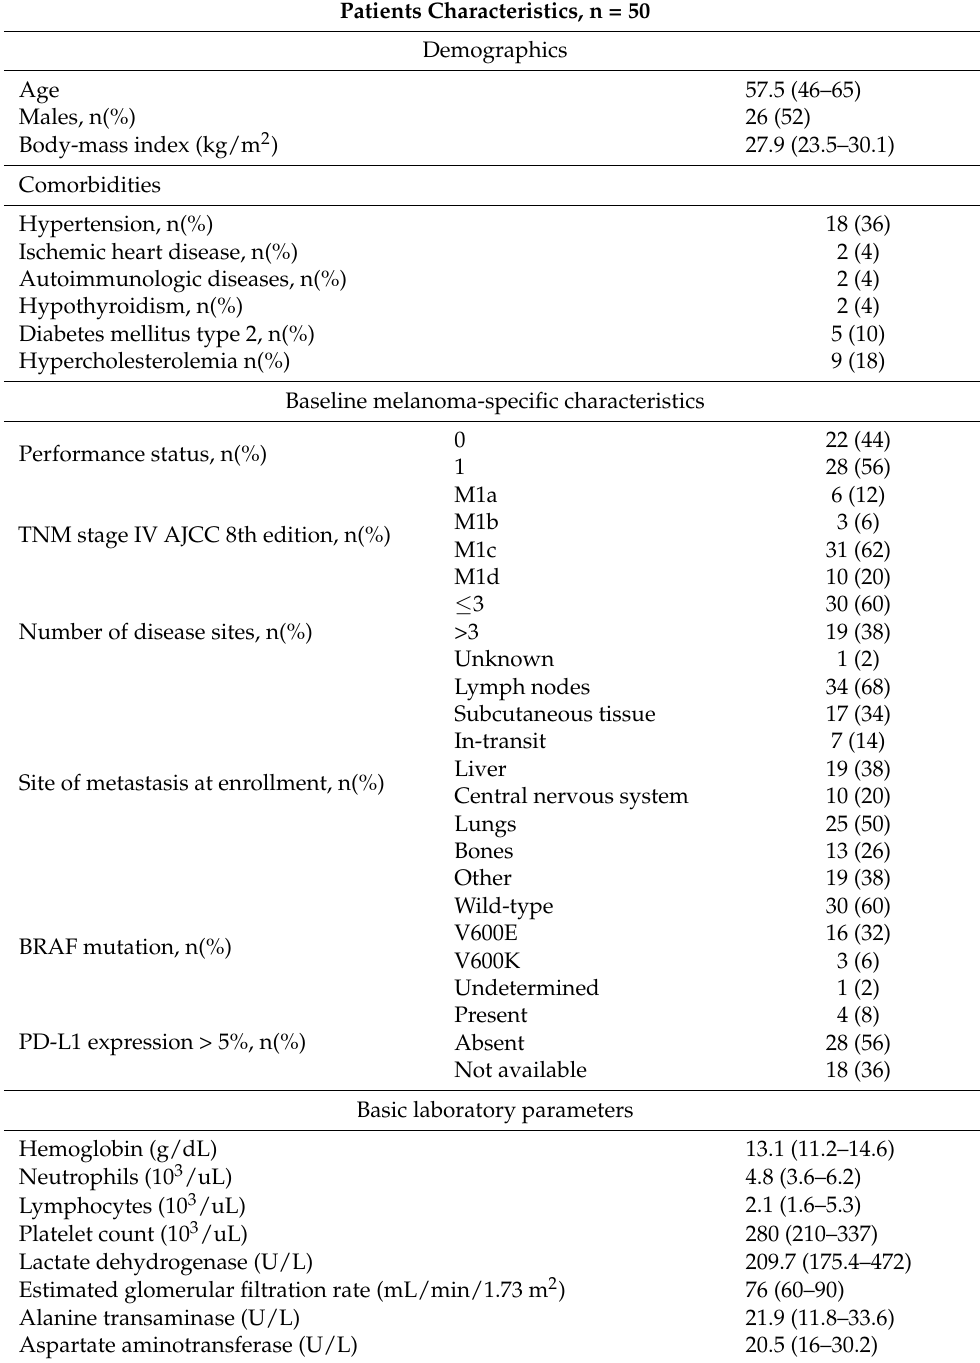
Table 1. Demographic and clinical characteristics of melanoma patients at enrollment (n = 50), including past oncological treatment and basic laboratory test